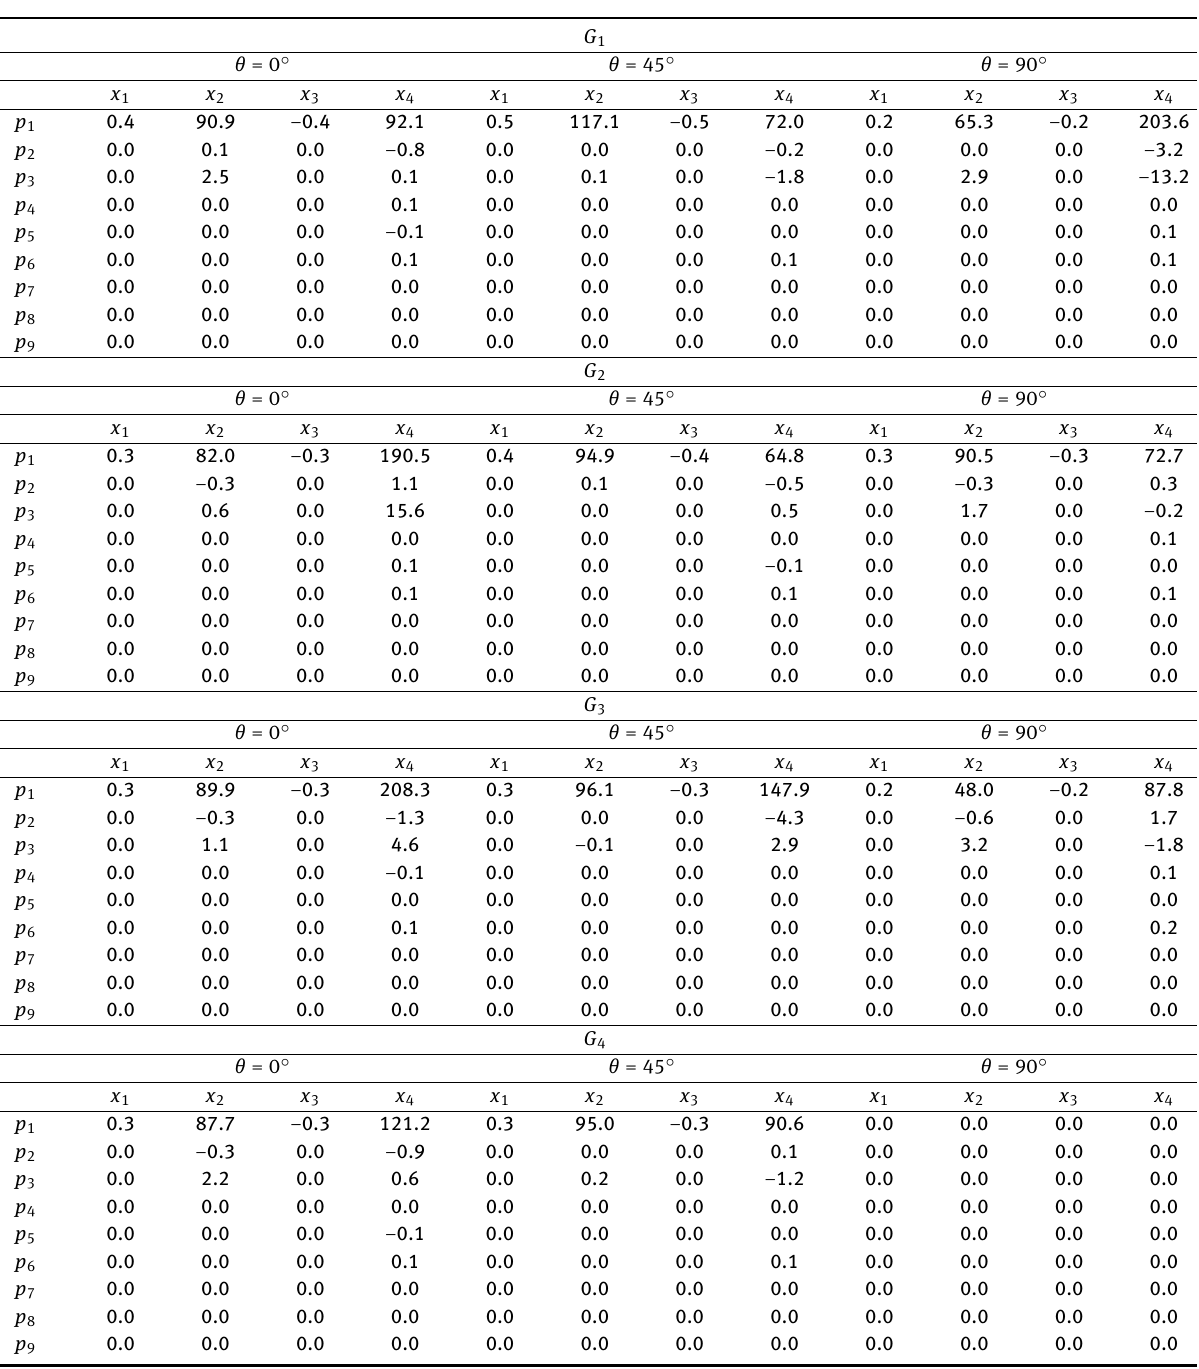
Table A4: Polynomial surface fitting coeflcients ( i.e. , · 10 −3 ) for square plan